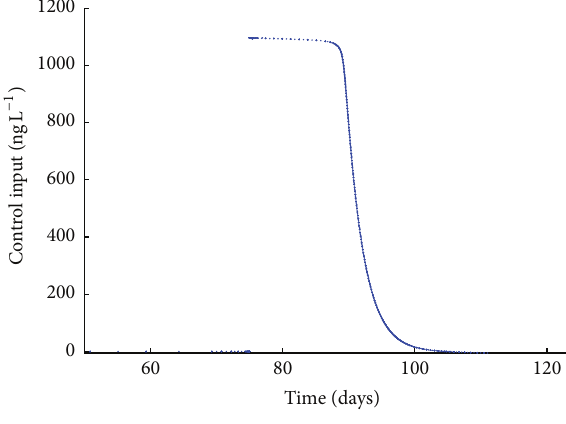
Figure 6: Control’s effort for the proposed controller.